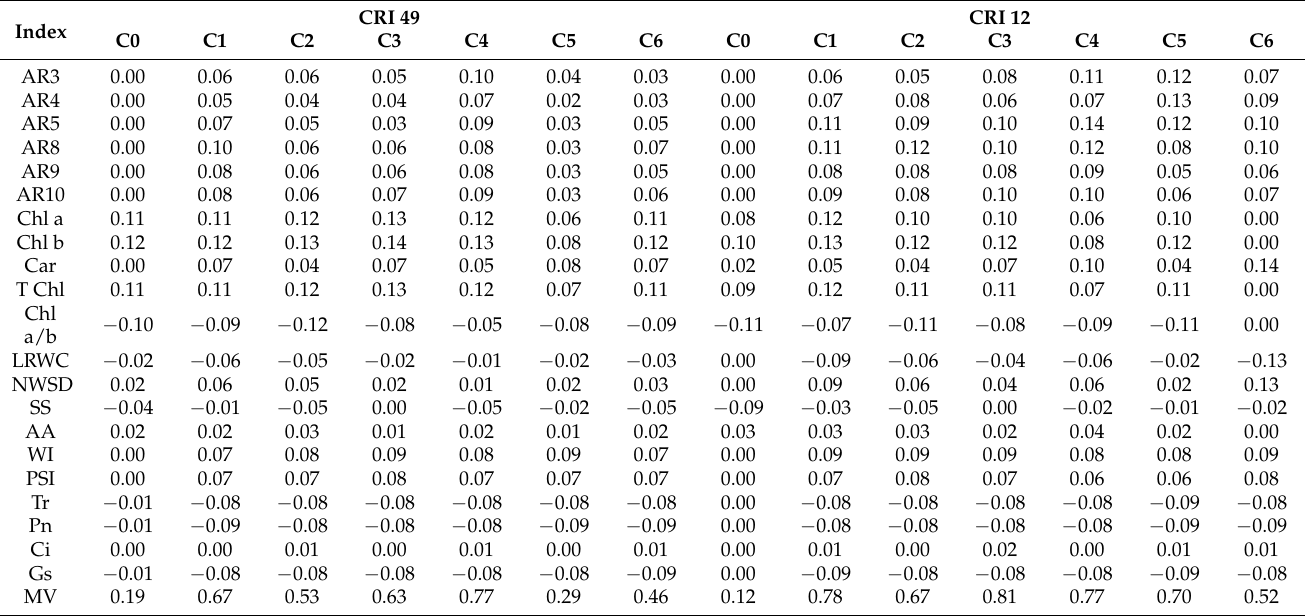
Table 2. Leaf abscission sensitive evaluation by membership function value (MFV)